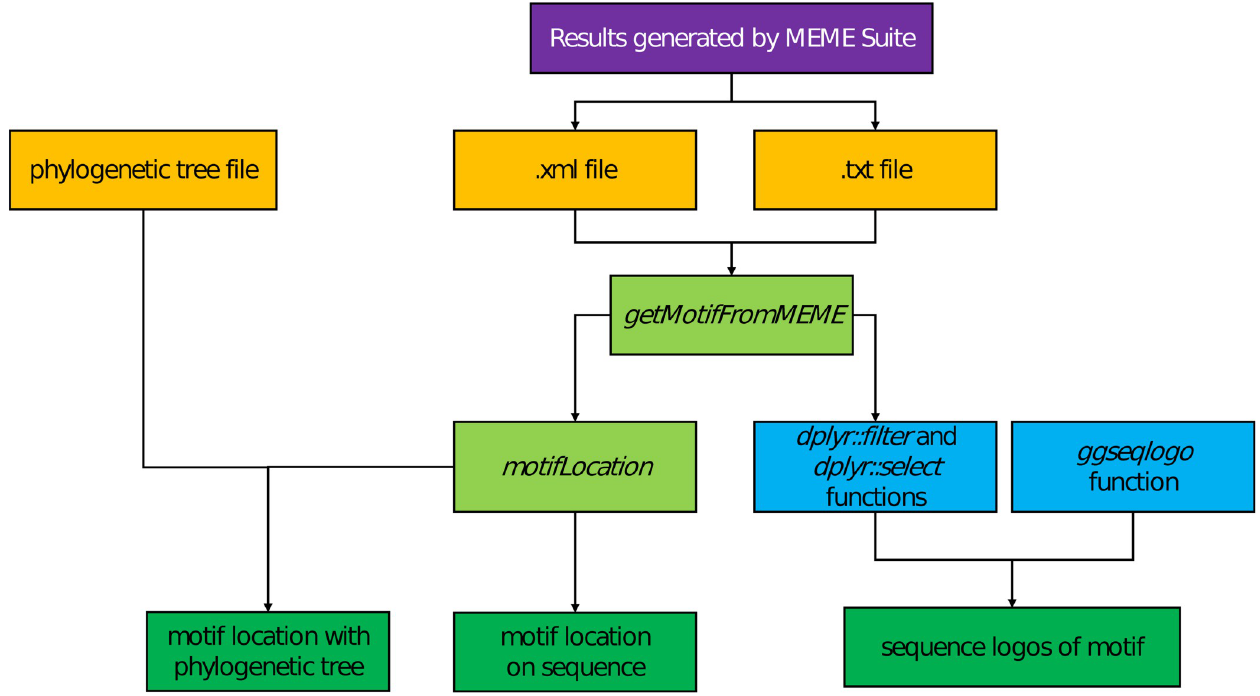
Fig 1. ggmotif workflow. The ggmotif workflow consists of several functions, including the ggmotif package, ggtree package, and ggseqlogo package.